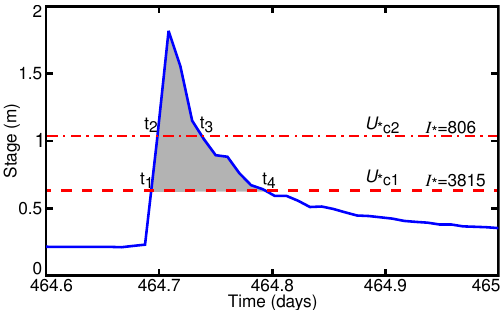
Figure 4. Calculation of the dimensionless impulse ( I ∗ ) for two estimates of U ∗ c for a single flood, where the time represents the floods location on the hydrograph in Fig. 2a. The limits of integra- tion for U ∗ c1 and U ∗ c2 are t 1 to t 4 and t 2 to t 3 , respectively. The shaded region represents the region integrated for the calculation of I ∗ using U ∗ c1